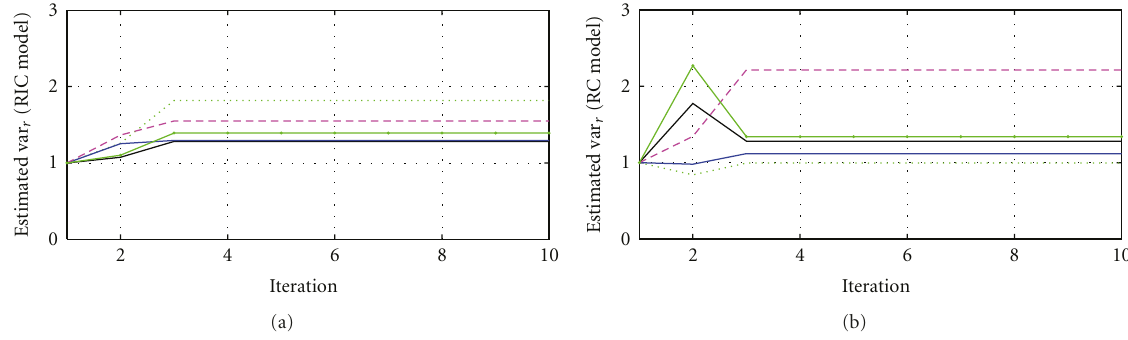
Figure 4: Estimated measurement noise variance produced by representative COPD patient (a) for RIC model and (b) for nonlinear RC model.